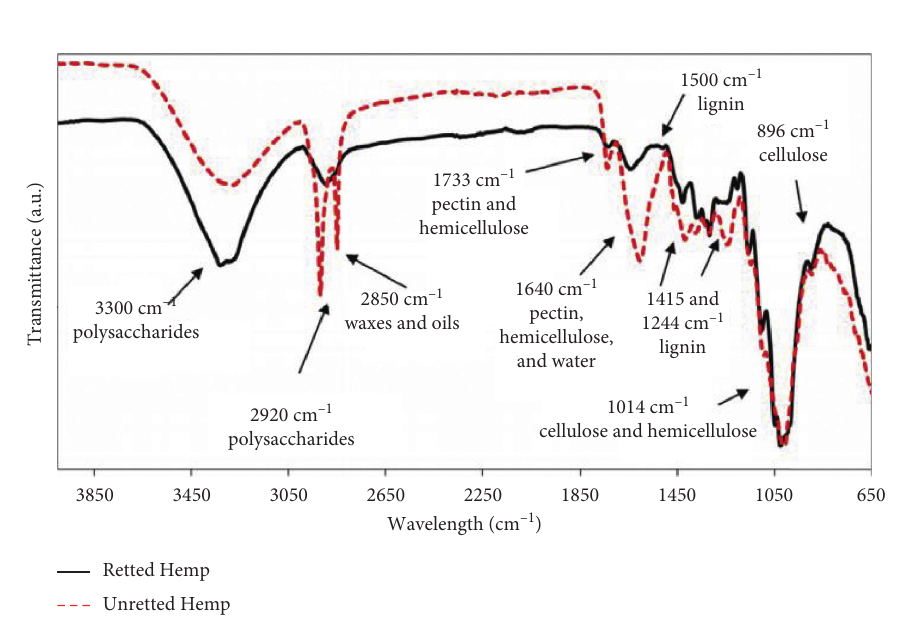
Figure 16: ATR-FTIR spectroscopy for enzymatic retted and unretted hemp fibres [57].